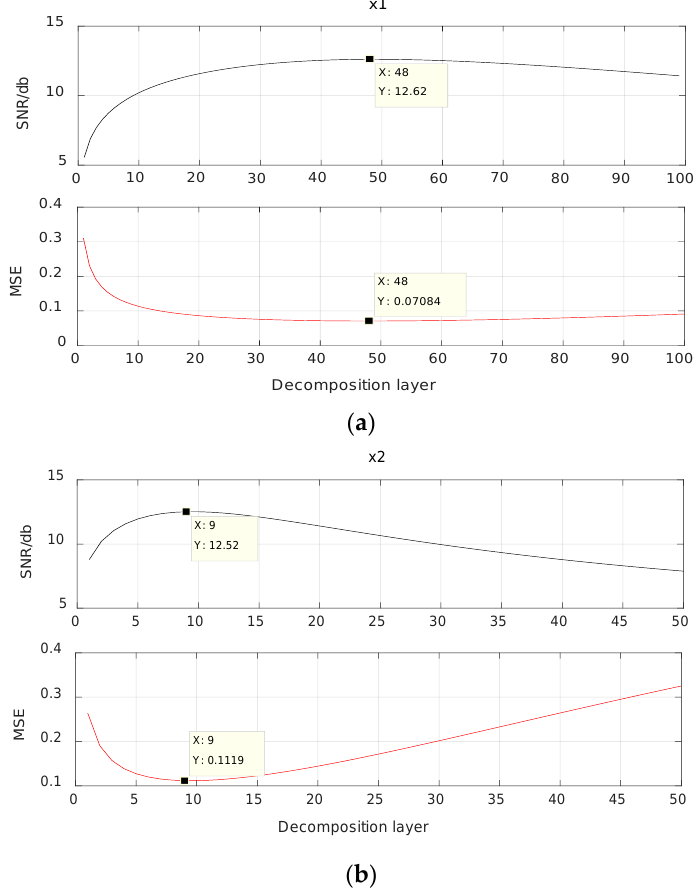
Figure 3. The SNR and MSE in the two-division method. ( a ) X 1 , ( b ) X 2 .